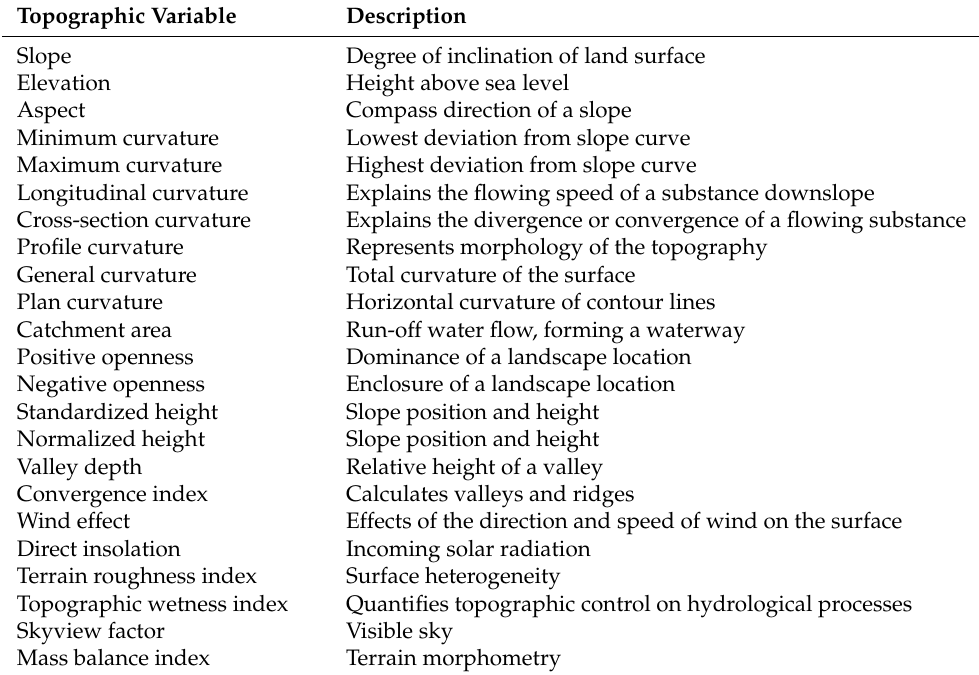
Table 2. Topographic variables used in this study as explained in Odebiri, Mutanga